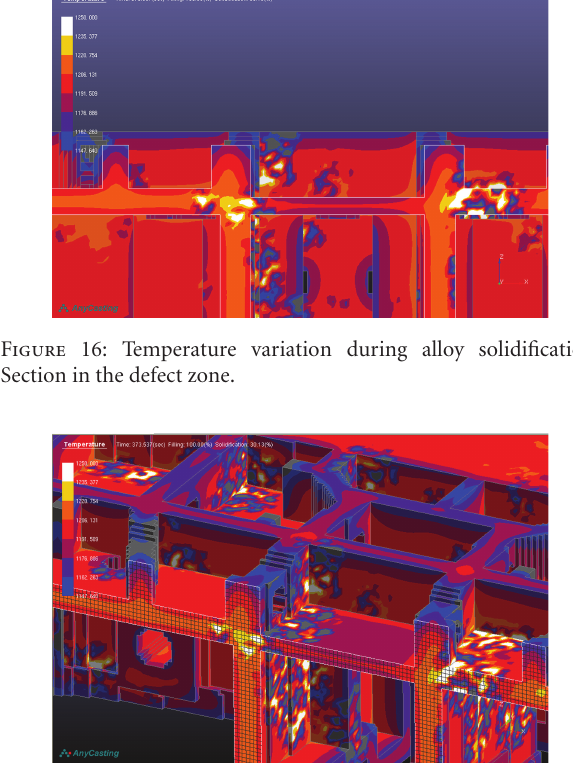
Figure 17: Temperature variation during alloy solidification. Meshed section in the defect